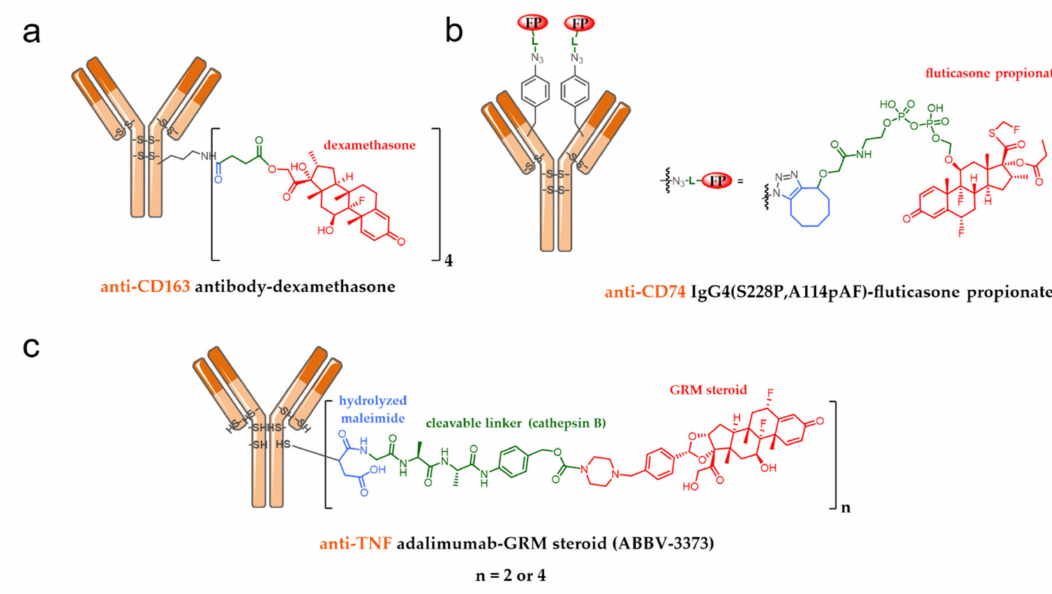
Figure 17. ( a ) Formula of an ADC resulting from the conjugation of dexamethasone onto an anti-CD163 mAb, with a DAR of 4. ( b ) Formula of an ADC resulting from the site-specific conjugation of fluticasone propionate onto an anti-CD74 IgG4 mutated mAb, with a homogeneous DAR of 2. ( c ) Formula of an ADC resulting from the conjugation of a dexamethasone analog onto anti-TNF- α adalimumab, with a DAR of 2 or